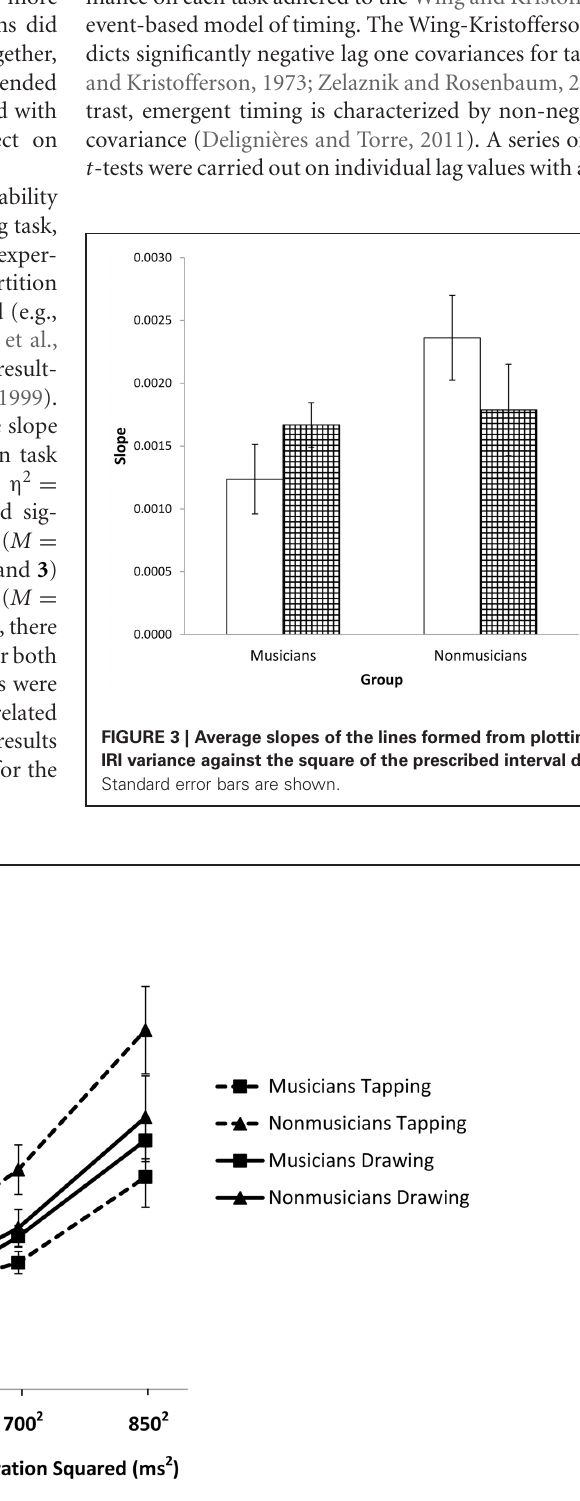
Frontiers in Human